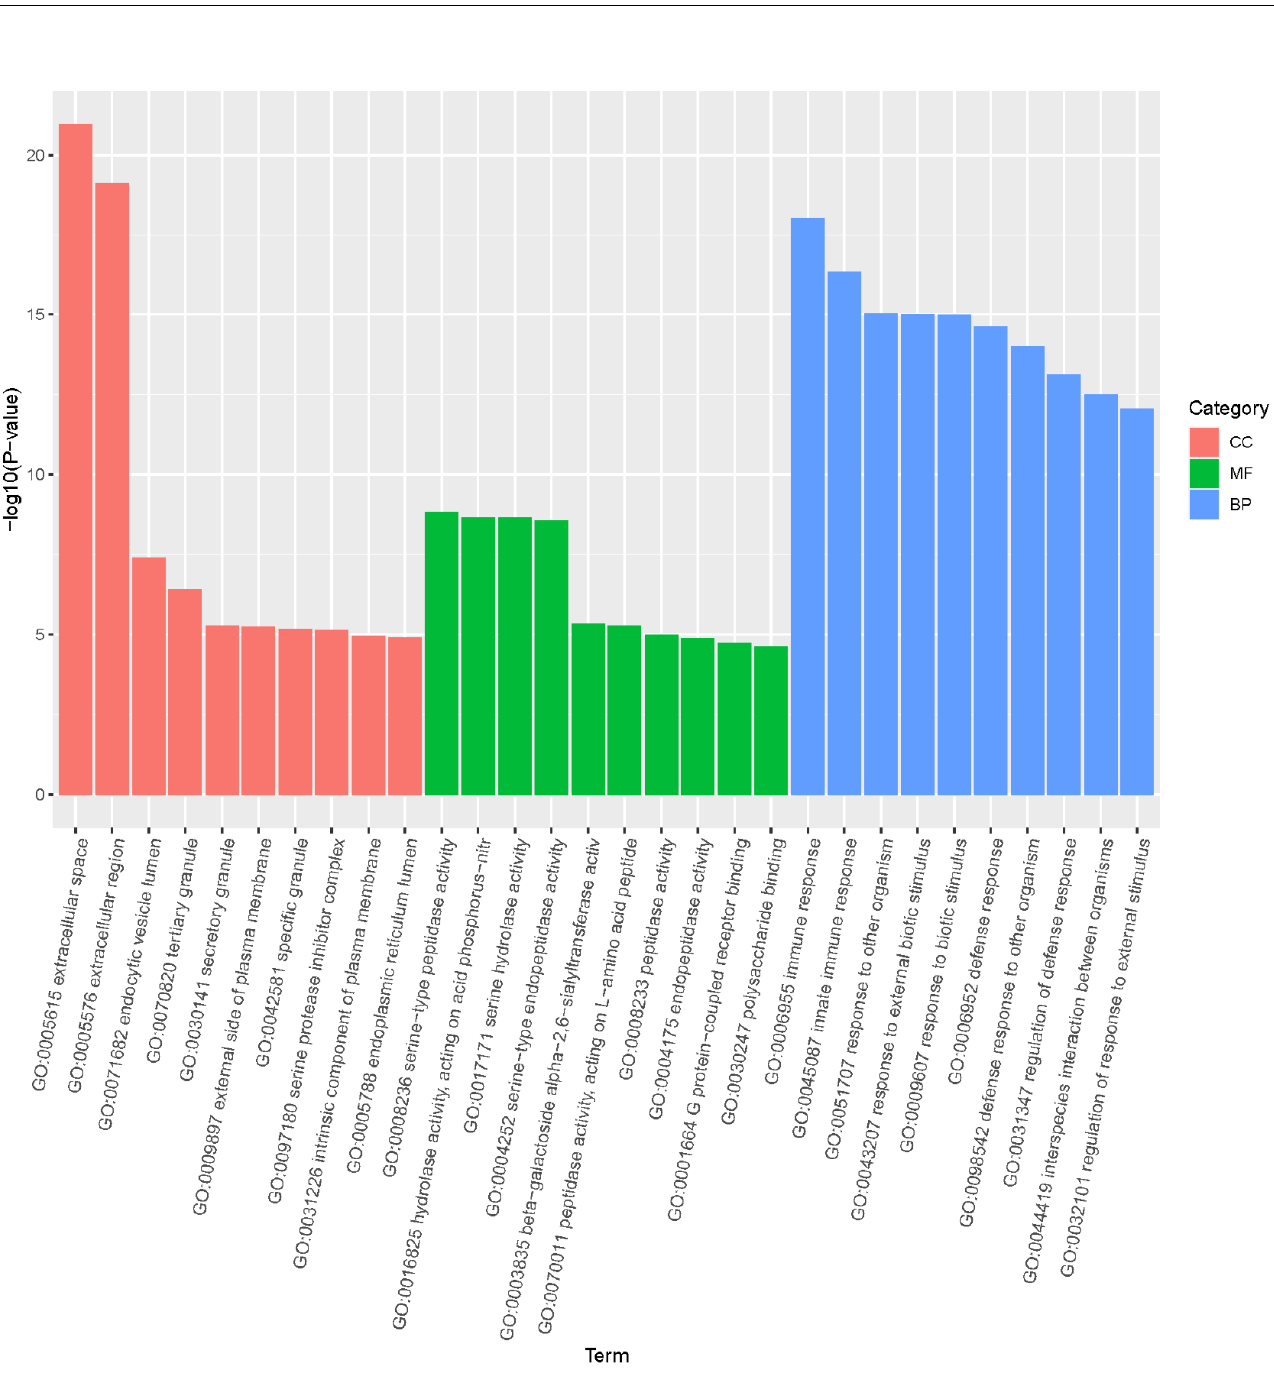
Figure 3. Gene ontology (GO) analysis of differentially expressed genes. The top 30 GO terms identified ( p < 0.05 and the unigene number of GO terms were >2) for biological processes, cellular components, and molecular functions are presented. (For interpretation of the references to color in this figure legend, the reader is referred to the web version of this article).